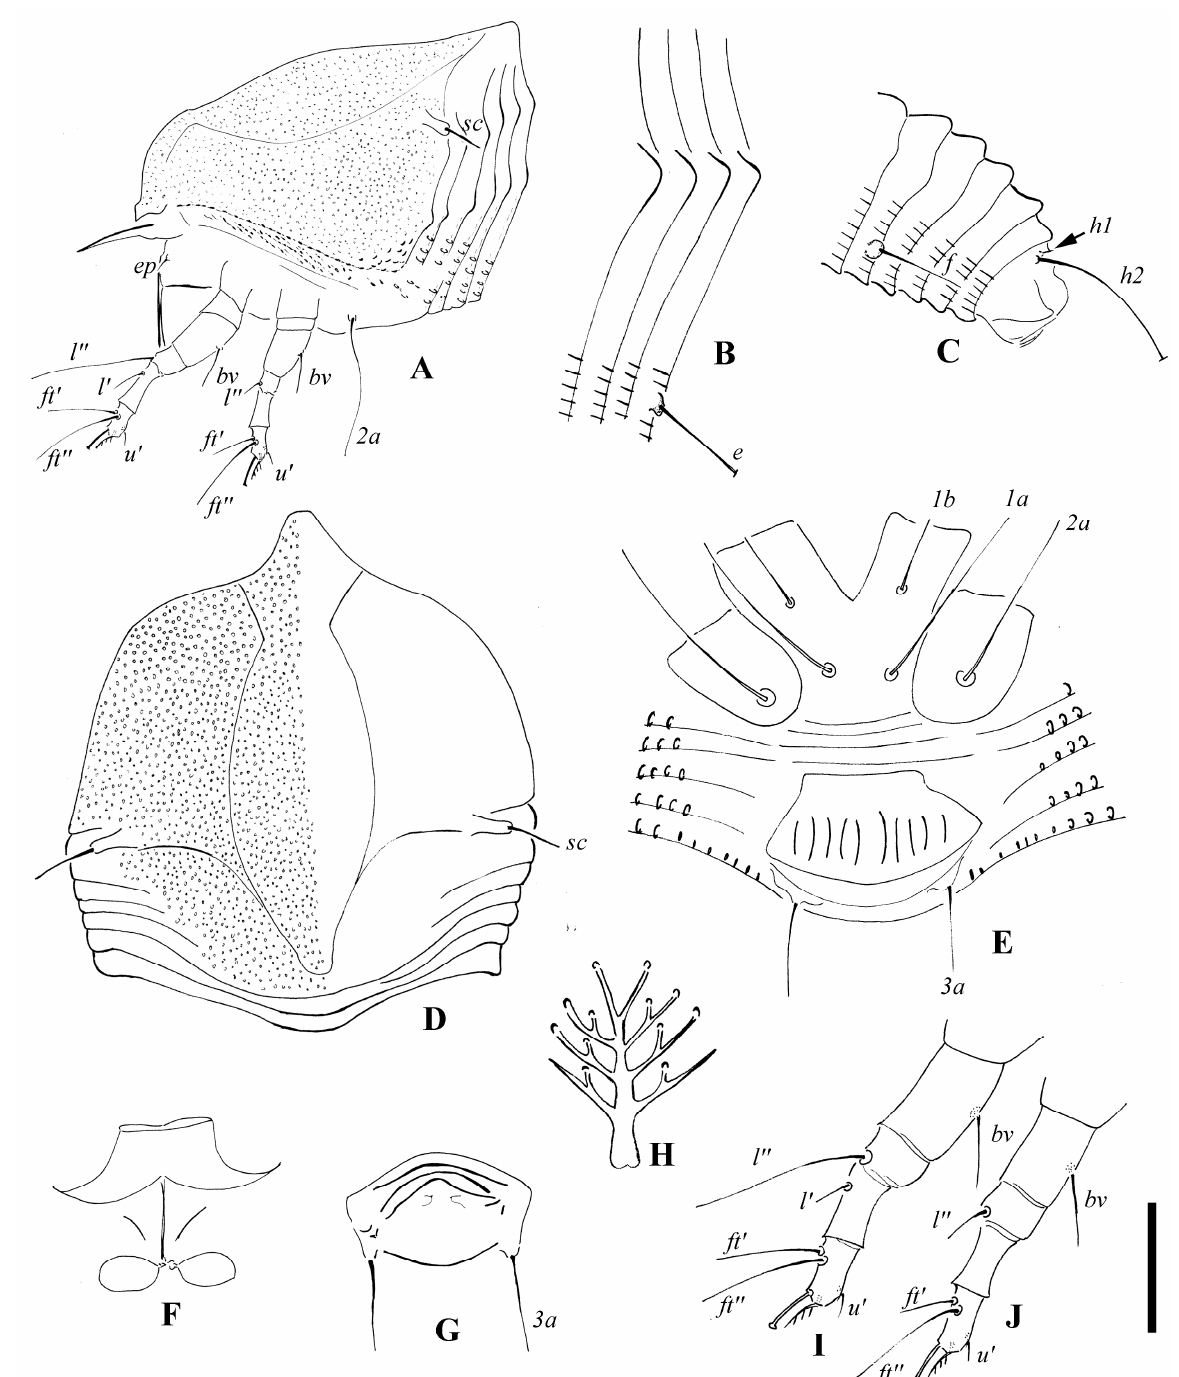
Figure 3. Scolotosus ehretus sp. nov. ( A ) lateral view of the anterior part of the body; ( B ) lateral microtubercles; ( C ) lateral view of the telosoma; ( D ) prodorsal shield; ( E ) female coxigenital area; ( F ) female internal genitalia; ( G ) male external genitalia; ( H ) empodium; ( I ) leg I ; ( J ) leg II. Scale bar: 18 µ m for ( A , C ); 15 µ m for ( D – G ); 12 µ m for ( I , J ); 3 µ m for ( B , H ). Italic letters depict the abbreviation of setae name.